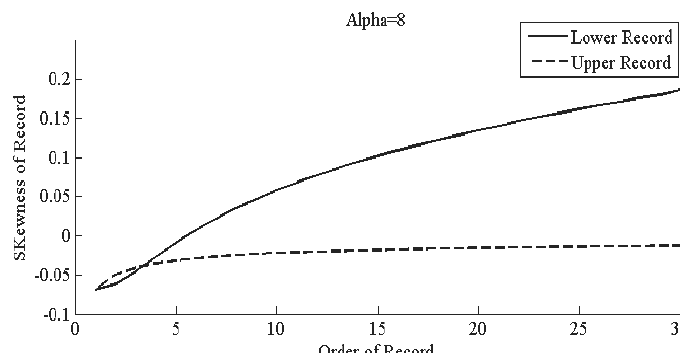
Figure 14 – Skewness coefficient of records.